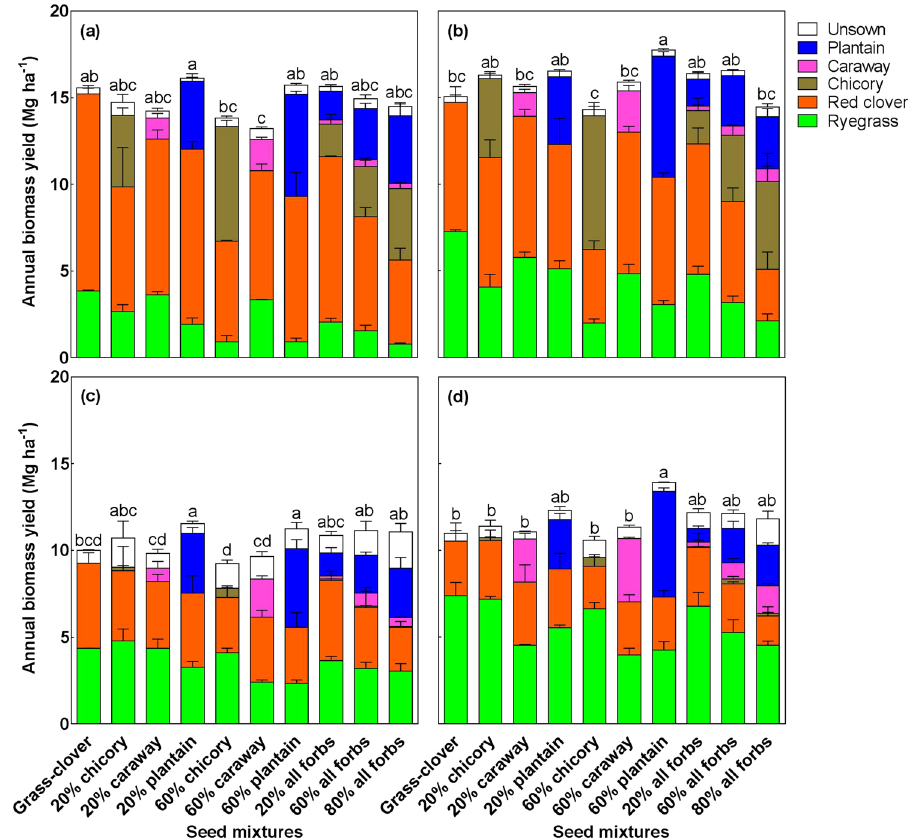
Figure 2. Annual biomass yield in the 10 seed mixtures in 2014 ( a , b ) and 2015 ( c , d ) without ( a , c ) and with ( b , d ) fertilisation. Data are means ± SE ( n = 3) for each component species. Means for seed mixtures with different lowercase letters are significantly different ( P < 0.05) using Tukey’s post hoc